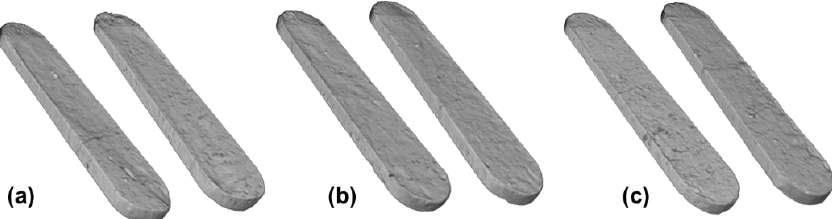
Figure 9. CT reconstruction of acid-etching morphology under different injection rates. ( a – c ) represents the injection rate of 40, 50 and 60 mL/min